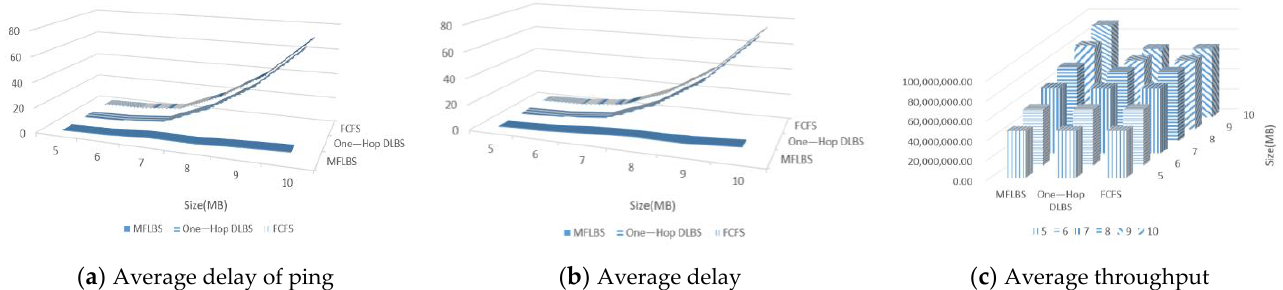
Figure 5. Three algorithms in FPN model under uniform pattern. Table 5. Average throughput (MB) in FPN model under uniform pattern.